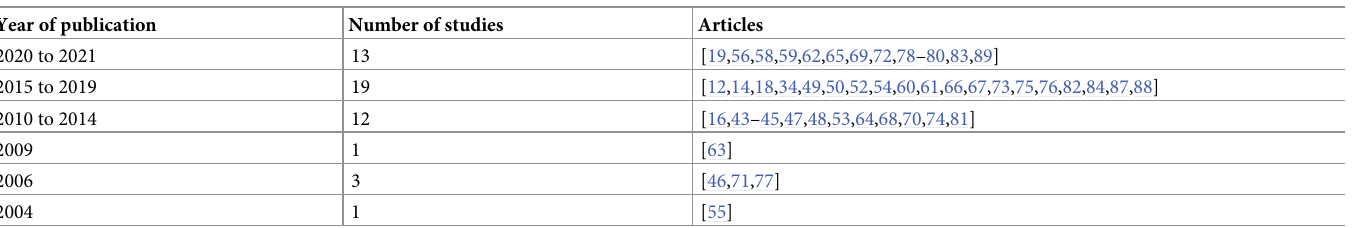
Table 3. Year of publication of included